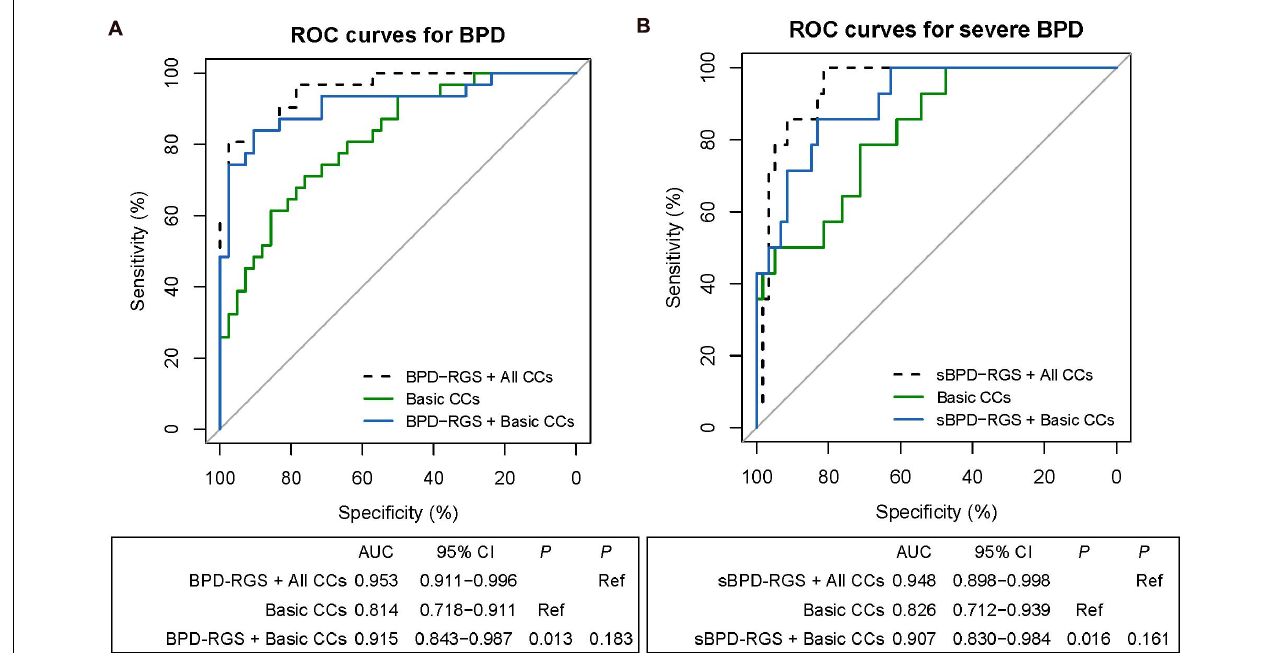
FIGURE 3 | Receiver operating characteristic (ROC) analyses of predictive models for infants with bronchopulmonary dysplasia (BPD) or severe BPD (sBPD). The comparisons of predictive models for BPD and sBPD. P -values show the areas under the ROC curves (AUROCs) between the different models. Clinical characteristics include the variables in a separate lasso model ( Supplementary Figure 1 ). (A) ROC analyses of the prediction of BPD by the combination of BPD–risk gene set (RGS) and all clinical characteristic model, the basic clinical characteristic model, and the combined BPD–RGS and basic clinical characteristics model. (B) ROC analyses of the prediction of severe BPD by the combined sBPDâ ˘A ¸SRGS and all clinical characteristic model, the basic clinical characteristic model, and the combined sBPD–RGS and basic clinical characteristics model. CCs, clinical